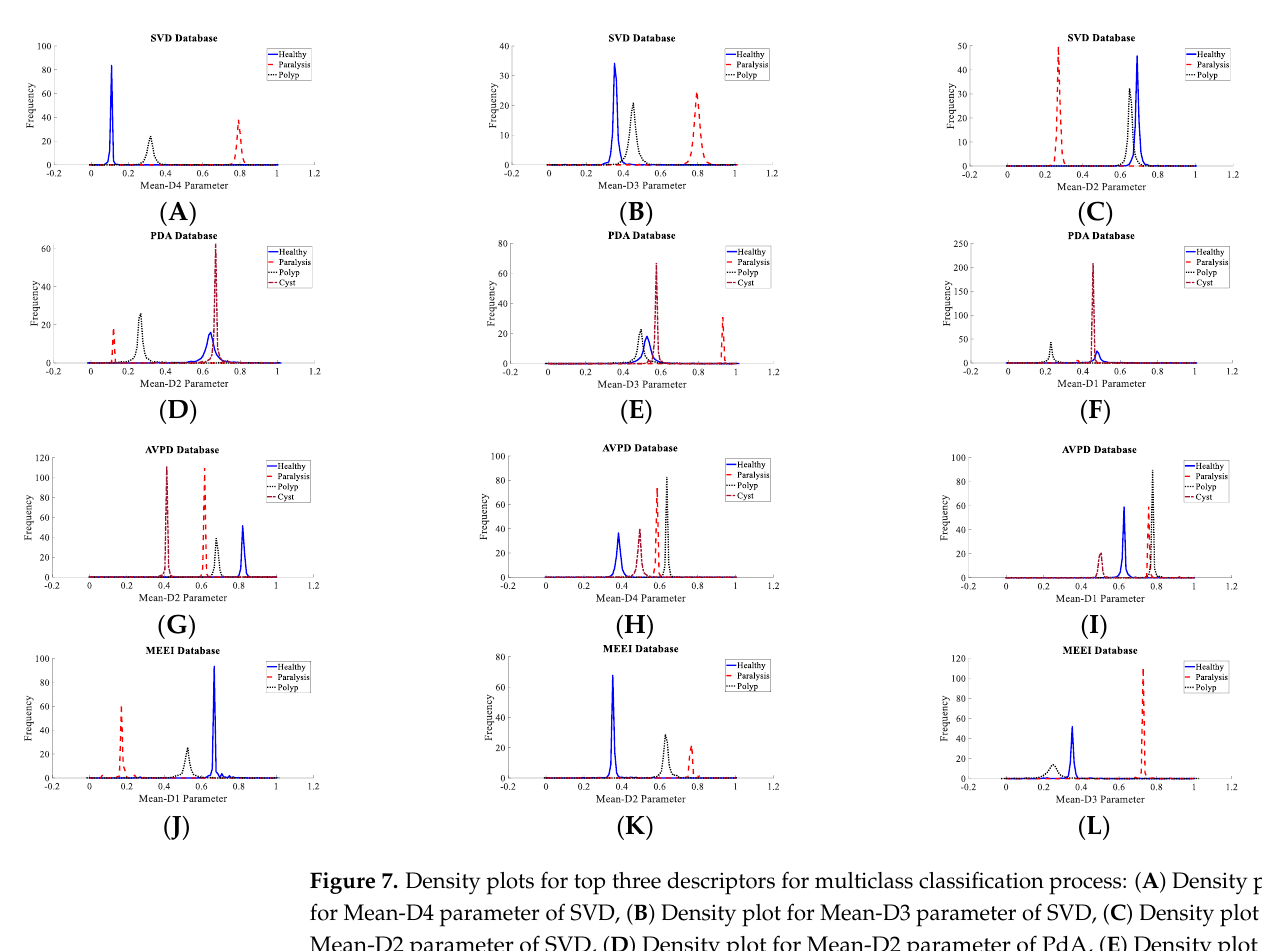
( L ) Figure 6. Density plots for the top three descriptors used in the diagnosis of voice illnesses: ( A ) Density plot for Mean-D3 parameter of SVD, ( B ) Density plot for Mean-D4 parameter of SVD, ( C ) Density plot for Mean-D1 parameter of SVD, ( D ) Density plot for Mean-D2 parameter of PdA, ( E ) Density plot for Mean-D3 parameter of PdA, ( F ) Density plot for Mean-D1 parameter of PdA, ( G )